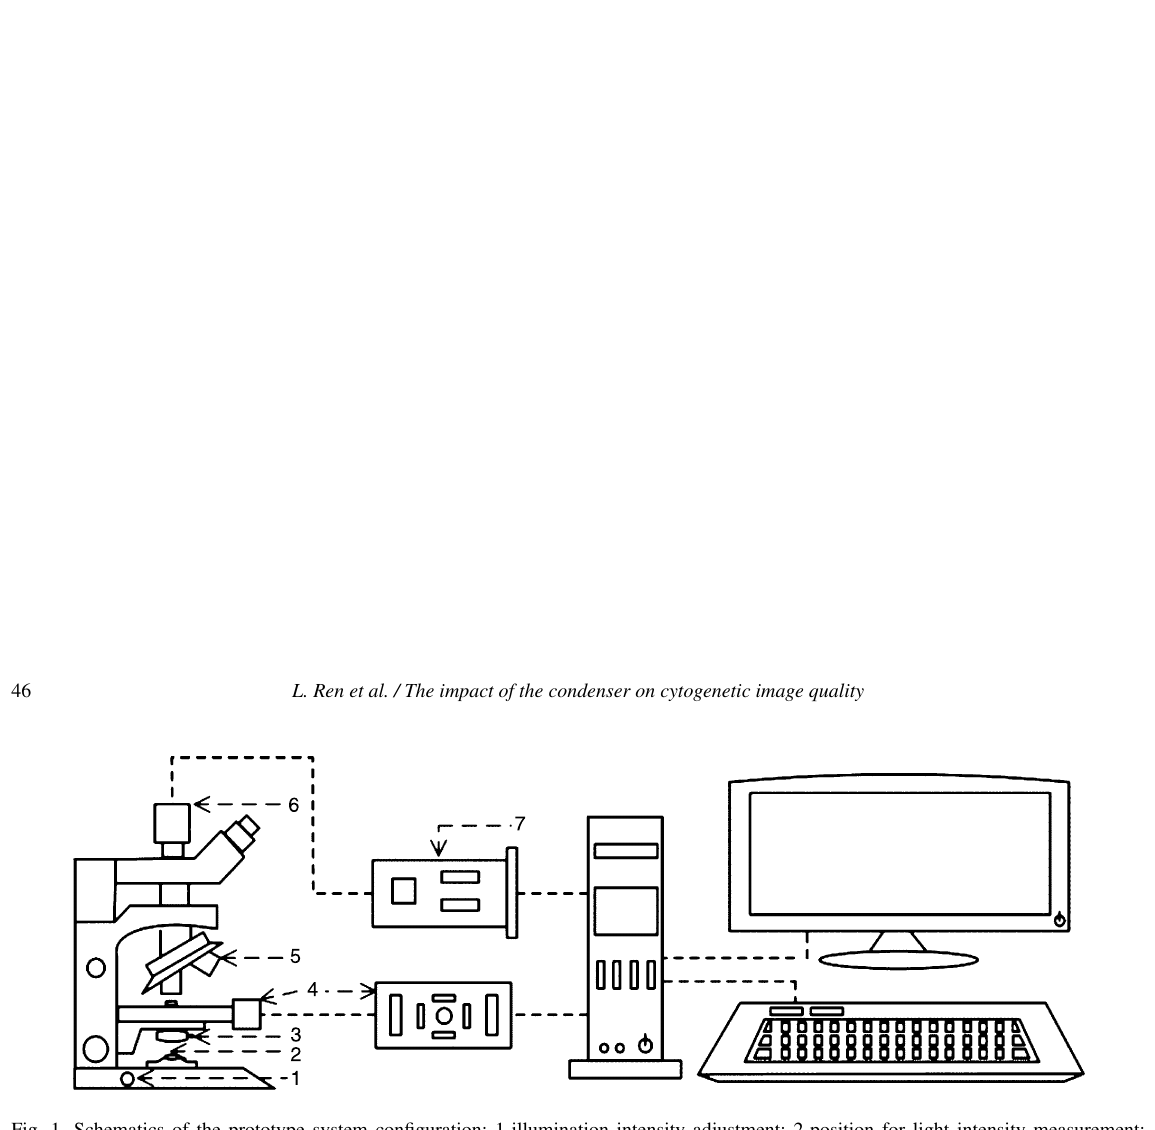
systems and the computer aided detection